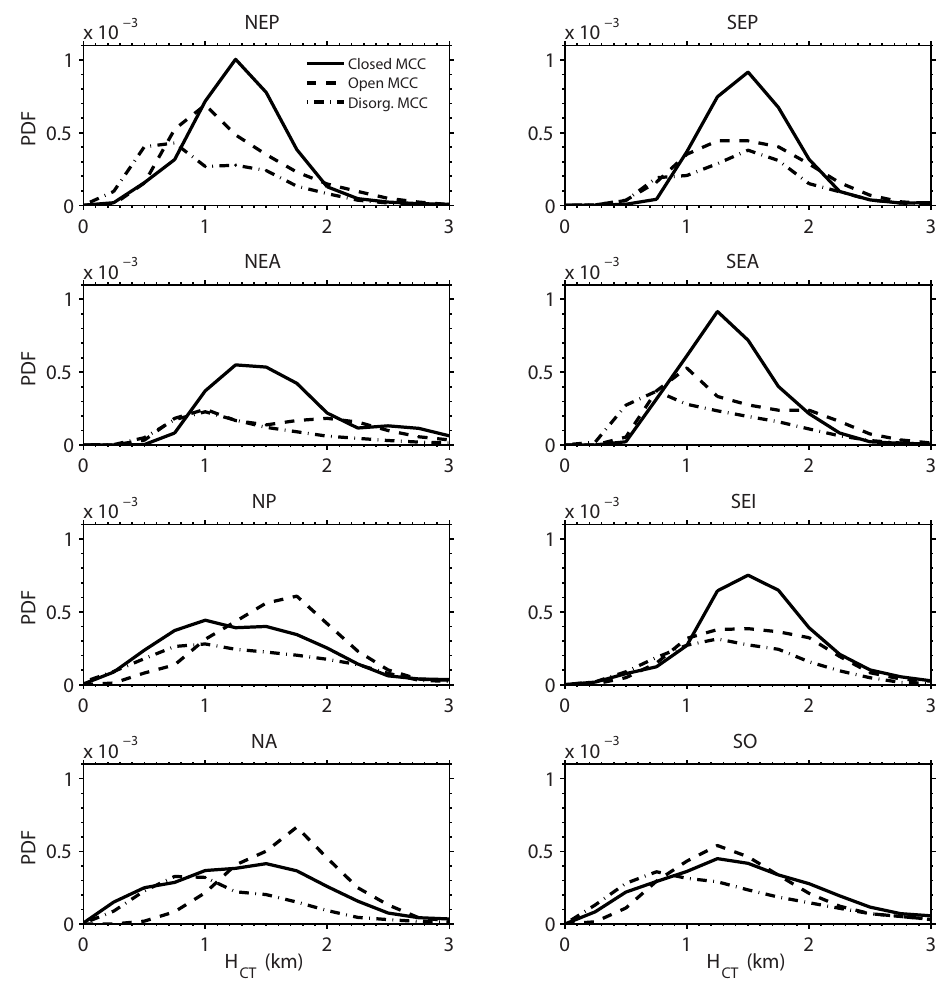
Figure 13. Same as Fig. 12 but for cloud top height ( H ct